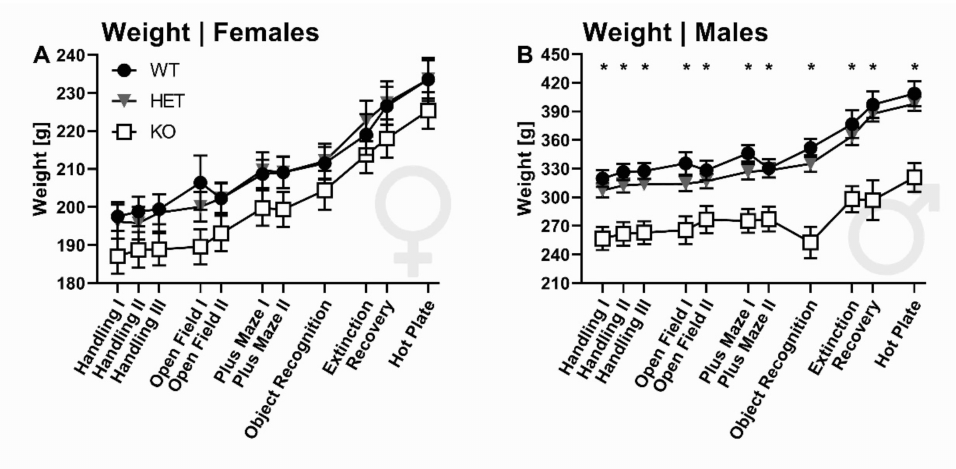
Figure 1. Body weight. Effects of SERT deficiency on body weight across different testing procedures for ( A ) female and ( B ) male SERT +/+ (black circles), SERT +/ − (grey triangle), and SERT − / − (white square) rats. N = 44 female rats (15 +/+, 15 +/ − , 14 − / − ), N = 43 male rats (14 +/+, 15 +/ − , 14 − / − ). Data are presented as mean ± SEM. * p < 0.05 effect of genotype, as compared to SERT +/ − and SERT +/+